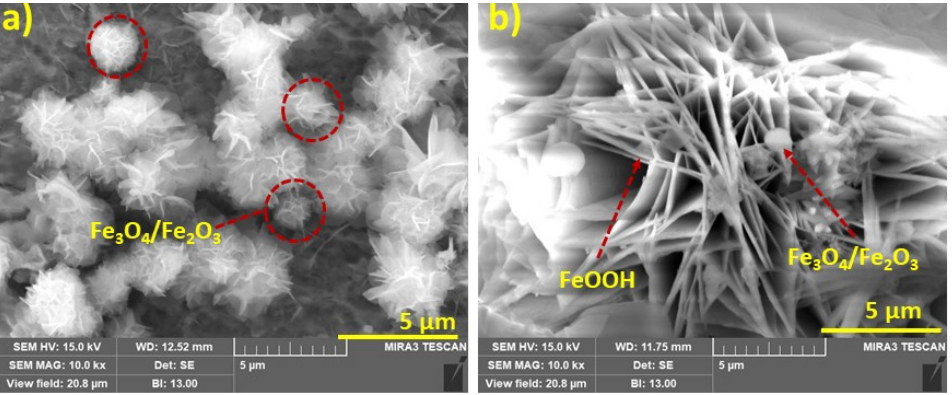
Figure 10. SEM micrographs of the corrosion products on the steel rebar surface after an exposure period of 30 days [O-SSSA0 ( a ); and O-SSA20 ( b )].